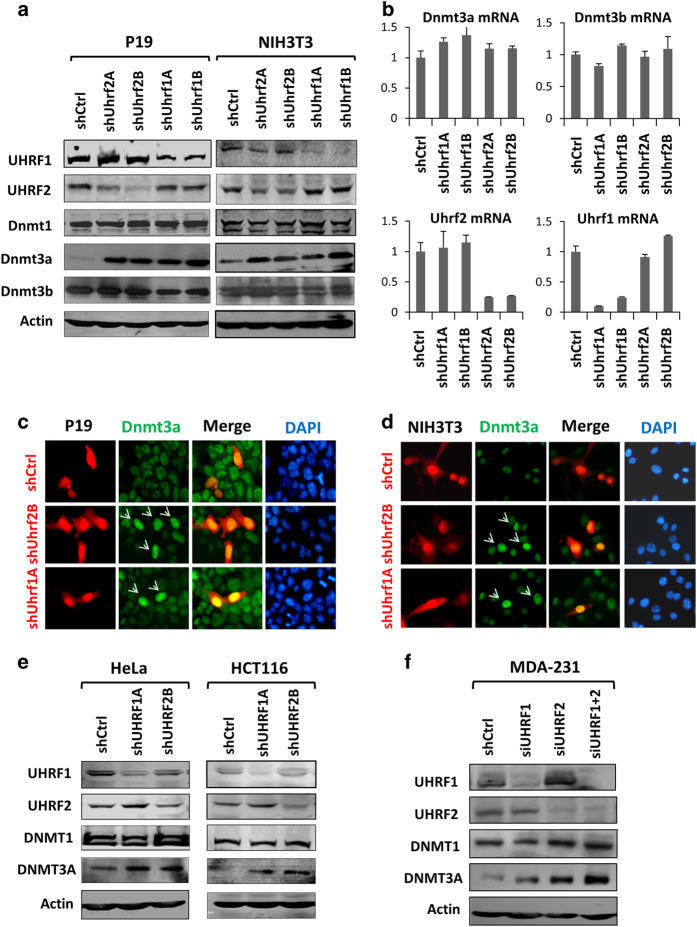
Both UHRF2 and UHRF1 negatively regulate DNMT3A post-transcriptionally in mouse and human cancer cells. (a) Western blot analysis of Dnmt1, Dnmt3a and Dnmt3b upon knockdown of Uhrf1 or Uhrf2 in mouse P19 and NIH3T3 cells. Knockdown of Uhrf1 or Uhrf2 was achieved by lentiviral-mediated shRNA infection. (b) qRT-PCR analysis of the levels of Dnmt3a and Dnmt3b mRNAs in shUhrf1- or shUhrf2-infected P19 cells. The knockdown of Uhrf1 or Uhrf2 was verified by qRT-PCR analysis. Bars and error bars represent mean values and s.e.m. from three measurements, respectively. (c, d) Immunostaining analysis of Dnmt3a proteins for P19 cells (c) and NIH3T3 cells (d) transfected with control shRNA vector or shRNA against Uhrf1 or Uhrf2. Arrows indicate the cells transfected with either shUhrf2B or shUHRF1A. (e) Western blot analysis of DNMT1 and DNMT3A in whole-cell extracts derived from HeLa and HCT116 infected with lentiviruses encoding shUHRF1A or shUHRF2B. (f) Western blot analysis of DNMT1 and DNMT3A in breast cancer cell line MDA-231 infected with lentiviruses encoding shUHRF1A or shUHRF2B or both. Note the double knockdown of UHRF1 and UHRF2 resulted in a more pronounced increase of DNMT3A than knockdown of either one.